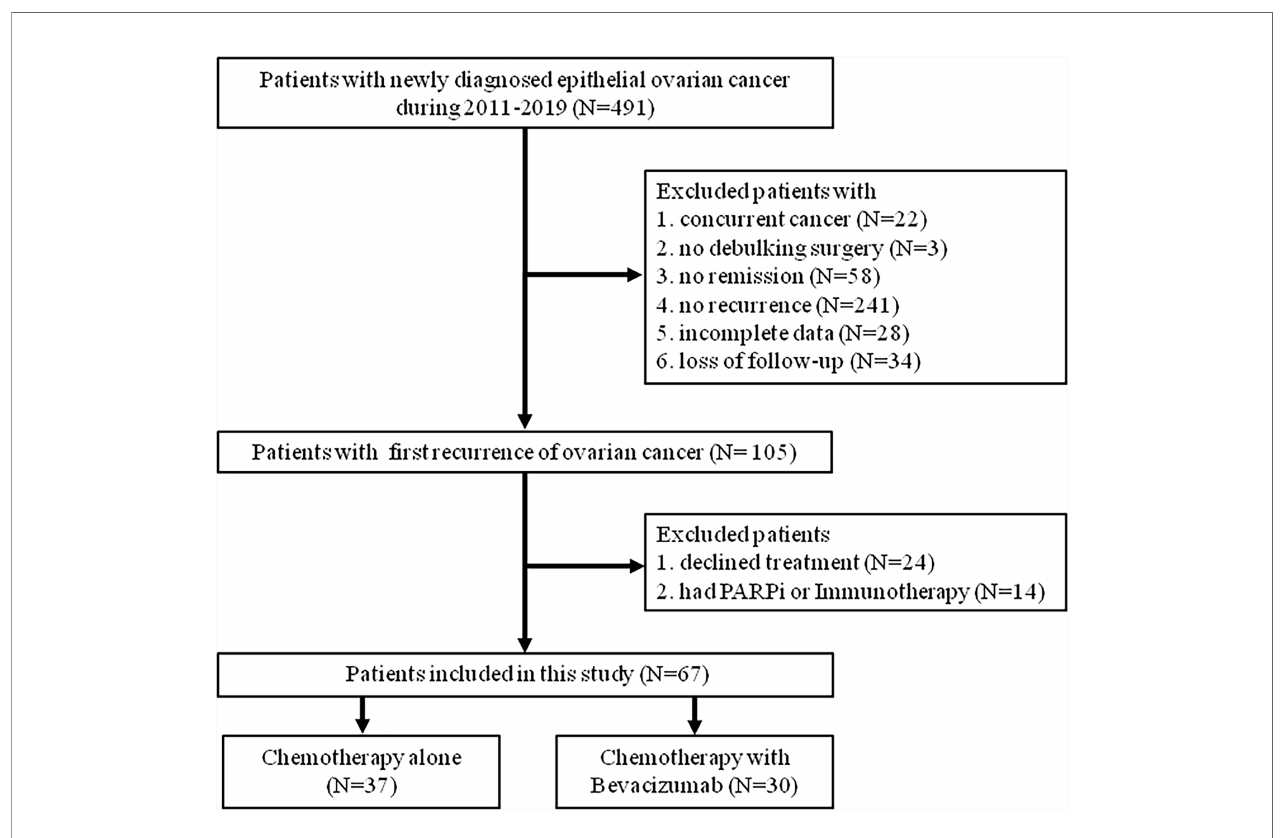
FIGURE 1 | Study fl ow chart for population